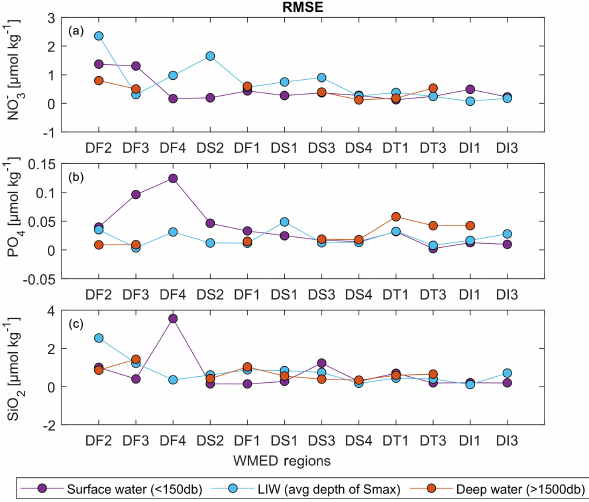
Figure 10. RMSE regional averages of water mass properties com- puted between the new adjusted product and MEDAR/MEDATLAS climatology for nitrate (a) , phosphate (b) , and silicate (c) .